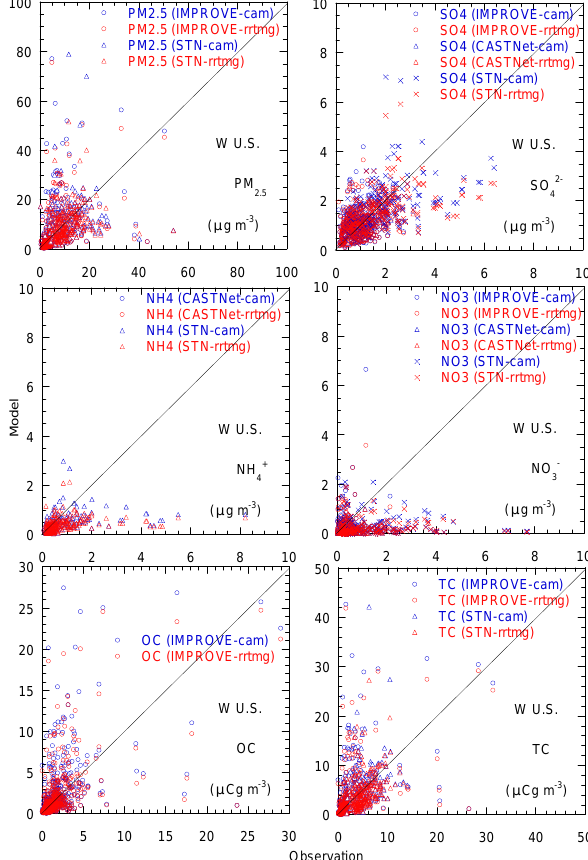
Figure 6a. Comparison of observed and modeled CAM (WRF– CMAQ/CAM) and RRTMG (WRF–CMAQ/RRTMG) PM 2 . 5 and its chemical composition at the IMPROVE, CASTNET and STN sites over the eastern US (longitude >100 ◦ ).